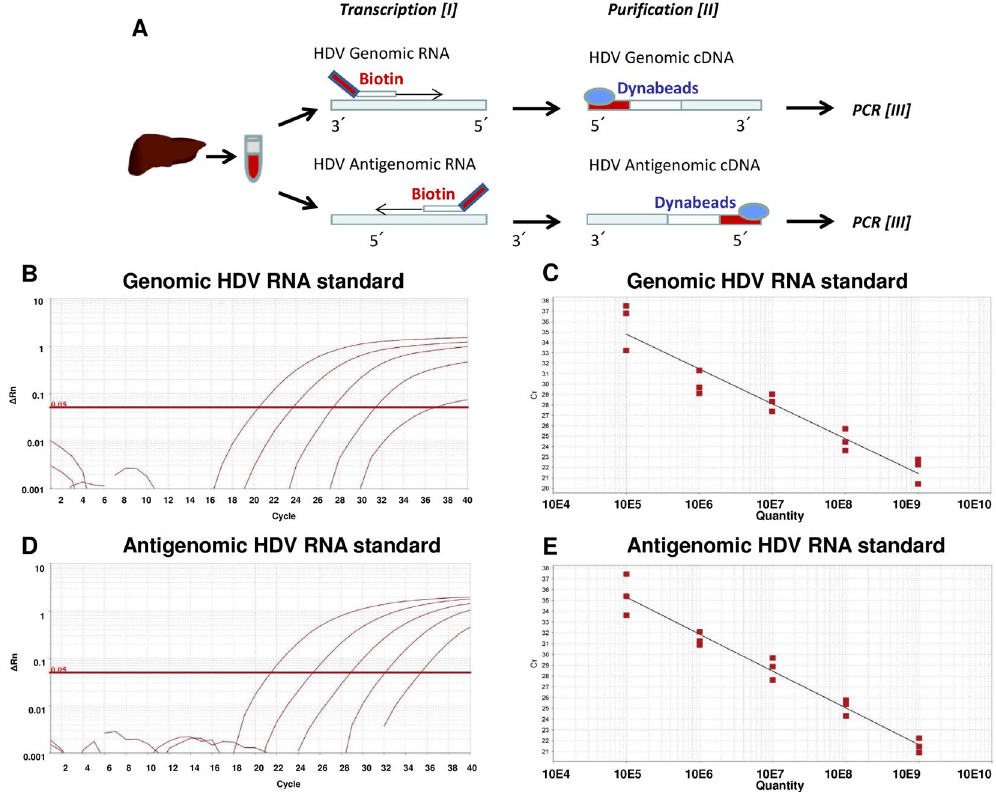
Figure 3. Establishment of strand-specific biotinylated magnetic beads (BMB)-based qRT-PCR assay and genomic/antigenomic HDV RNA standard curves. ( A ) HDV RNAs were separately reverse transcribed using biotinylated HDV specific genomic or antigenomic primer, purified with magnetic beads and then quantified by performing a qRT-PCR. B-E) Standard curves of genomic HDV RNA with a slope of − 3.351 and an efficiency of 98.8% ( B ) and antigenomic HDV RNA with a slope of − 3.417 and an efficiency of 96.2% ( D ). Amplification curves of 10 9 , 10 8 , 10 7 , 10 6 and 10 5 copies genomic ( C ) and antigenomic ( E ) HDV